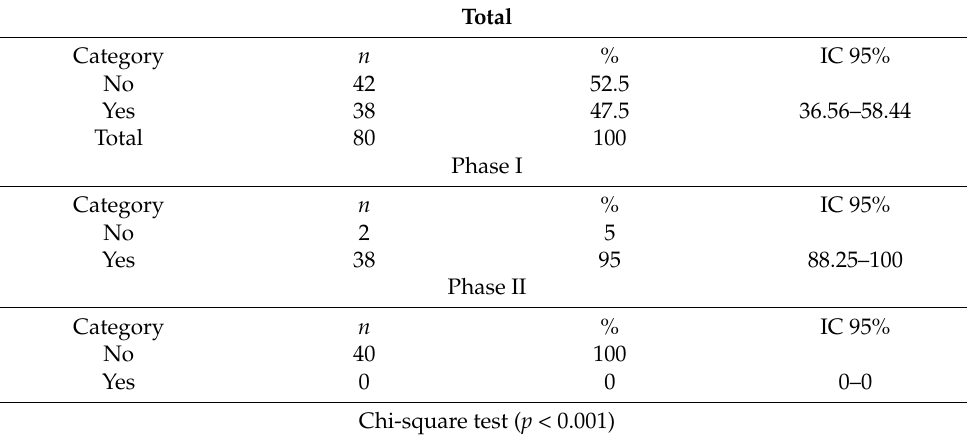
Table 3. Presence or absence of ischemia between phase I and phase II.